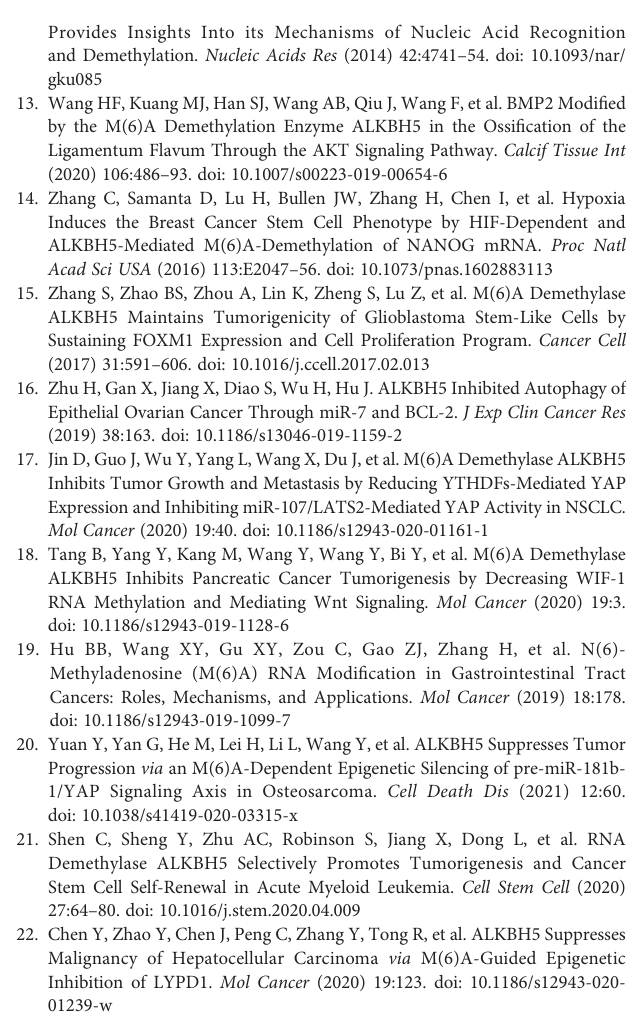
Supplementary Figure 8 | Correlation between ALKBH5 mRNA expression and ESTIMATE Score in glioma. The correlations between ALKBH5 mRNA expression level and ESTIMATE Score (P=5.5e-3, R=0.13) (A), Immune Score (P=0.02, R=0.09) (B) and Stromal Score (P=9.0e-4, R=0.13) (C) of glioma in TCGA dataset. Supplementary Figure 9 | Relationship between ALKBH5 expression and immune cell in fi ltration in glioma. Comparison of immune cell in fi ltration between ALKBH5 high expression and ALKBH5 low expression groups in glioma by CGGA_325 (A) , CGGA_693 (B) and TCGA (C) datasets via ImmuCellAl algorithm. Red asterisk represents the positive correlation between ALKBH5 expression and the level of immune cell in fi ltration, blue asterisk represents the negative correlation between ALKBH5 expression and the level of immune cell in fi ltration. *P<0.05, **P<0.01, ***P<0.001, ****P<0.0001. Supplementary Figure 10 | Correlation analysis between ALKBH5 and immune and in fl ammatory-related metagenes in glioma. Enrichment scores of seven immune and in fl ammatory-related metagenes in glioma patients with different ALKBH5 mRNA expression level status in CGGA_325 (A) , CGGA_693 (B) and TCGA (C) datasets. *P<0.05, **P<0.01, ***P<0.001, ****P<0.0001. Supplementary Figure 11 | Correlation between ALKBH5 and immune checkpoint (ICP) genesin glioma.Thecorrelation between ALKBH5expression and ICP genes (receptors and ligands) of glioma in CGGA_325 (A) , CGGA_693 (B) and TCGA (C) datasets. The red dots represent the positive correlation between